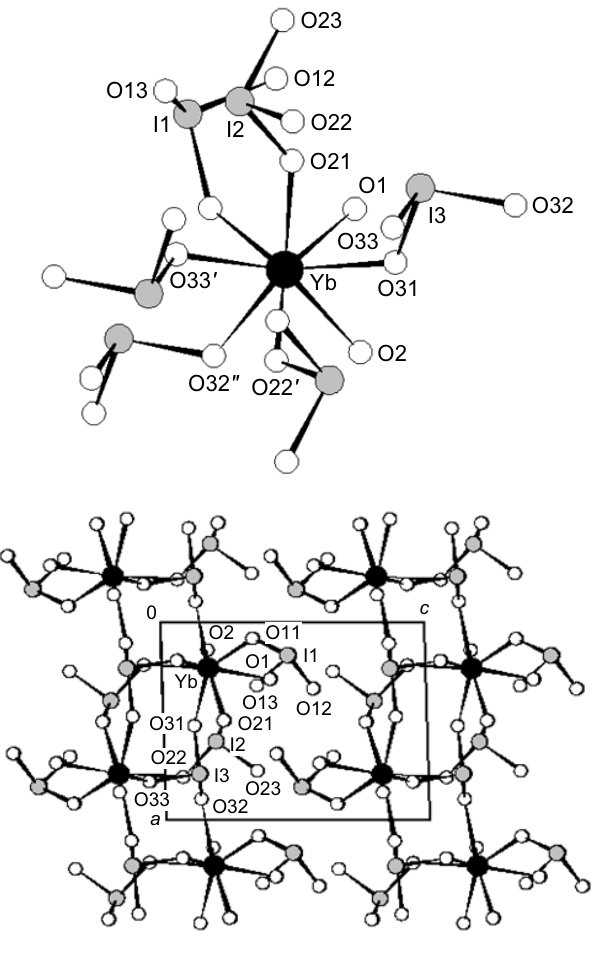
Source of material 0.25 mmol of ytterbium sulphate and 1.5 mmol of iodic acid